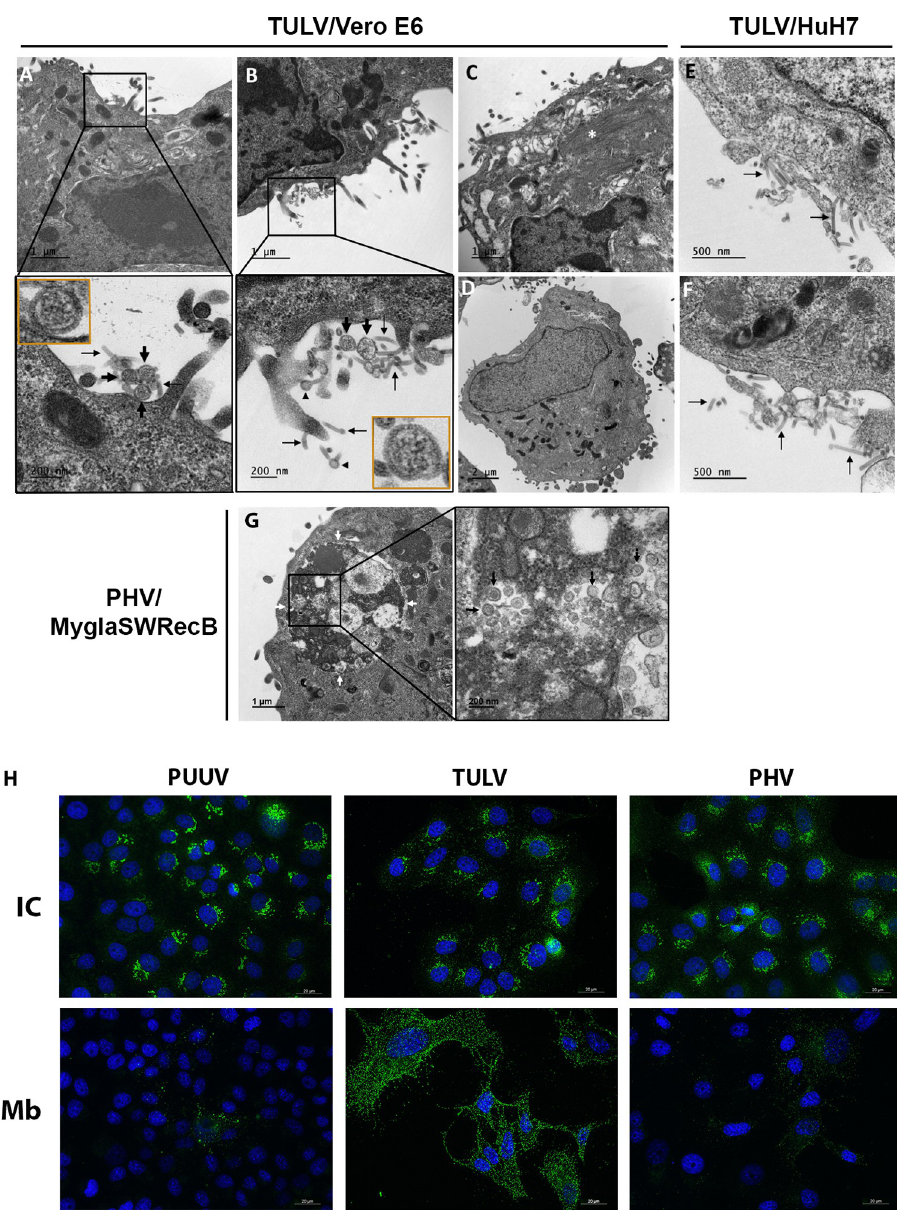
Fig 3. Maturation of viral particles assessed by electron microscopy and immunofluorescence assay. Panels A-G show thin sections of fixed cells processed by transmission EM. Vero E6 cells were either infected with TULV (A-C) or remained non-infected (D). The lower panels in A and B correspond to a magnification of the plasma membrane area framed by a square in the upper panels. Viral particles (insets), at the plasma membrane and in the extracellular space, are marked with large black arrows and tubular structures are indicated with thin black arrows. In (C), the white asterisk highlights the filamentous structure induced by TULV infection. HuH7 cells infected by TULV (E, F) only show tubular structures at the plasma membrane and the extracellular space (thin black arrows). Multivesicular vacuoles containing viral particles (black arrowheads) and their magnification are seen in MyglaSWRecB cells infected by PHV (G). Immunofluorescent staining of membrane (Mb) and intracellular (IC) viral glycoprotein Gn is shown in panel H for Vero E6 cells infected with PUUV, TULV and PHV. The scale bar corresponding to 20 μ m indicates the